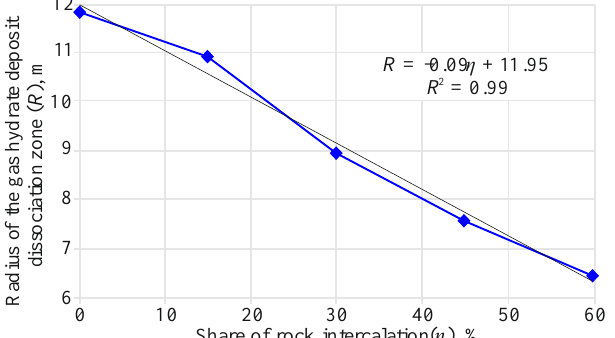
Figure 11. Dependence of a change in the radius of the dissociation zone on the share of rock intercalation.